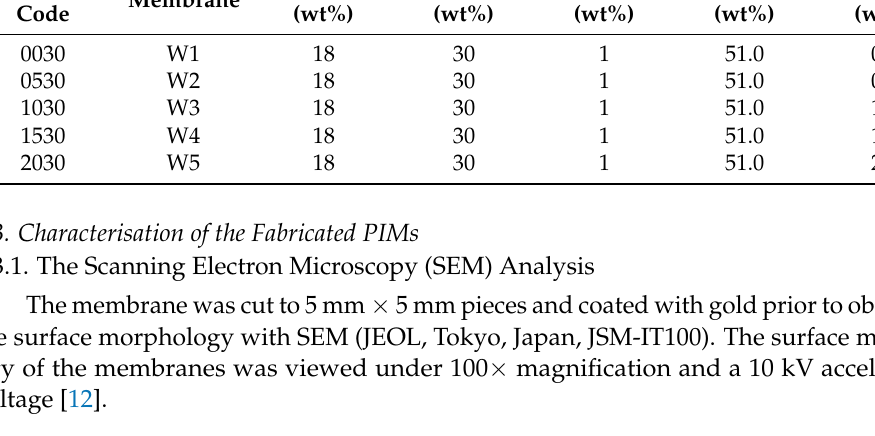
Table 2. Formulations of the MM-PIMs employed in the current study.